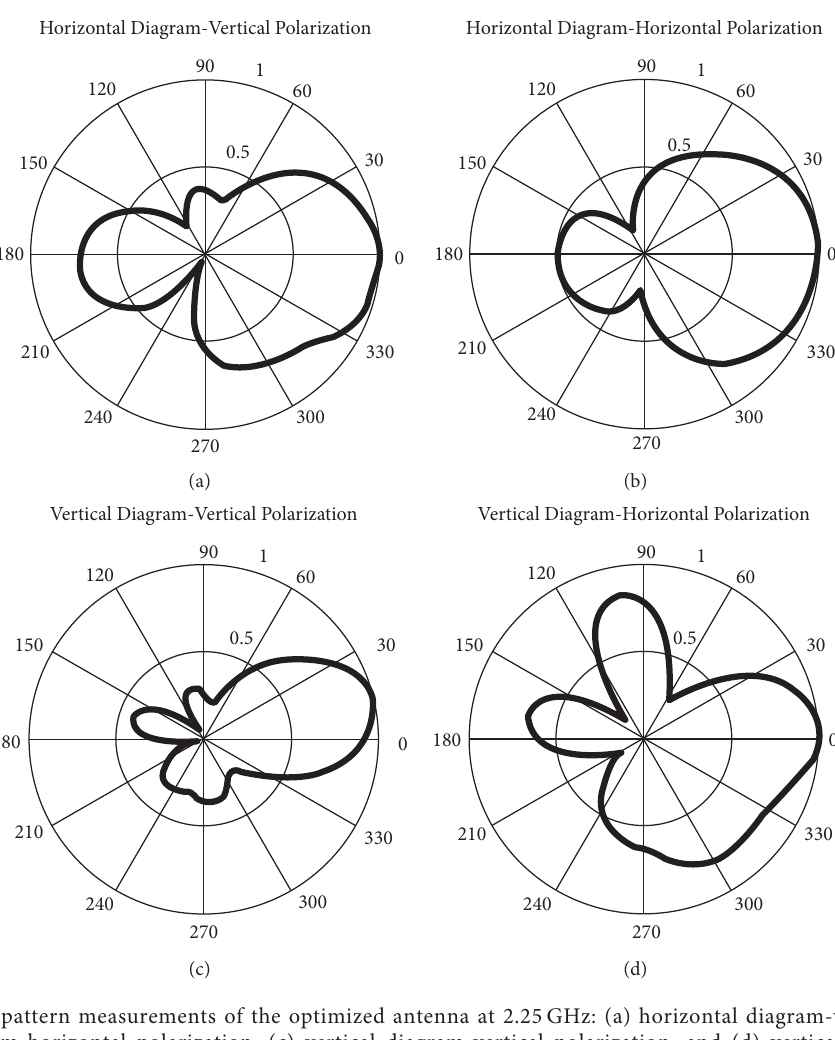
Figure 15: Radiation pattern measurements of the optimized antenna at 2.25 GHz: (a) horizontal diagram-vertical polarization, (b) horizontal diagram-horizontal polarization, (c) vertical diagram-vertical polarization, and (d) vertical diagram-horizontal polarization.